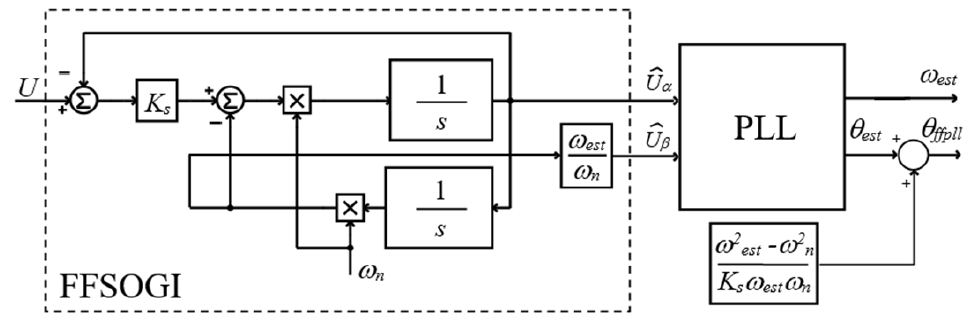
Figure 2. The basic structure of FFPLL1.